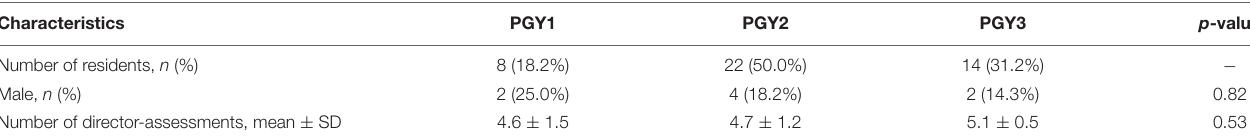
TABLE 3 | Characteristics of residents.